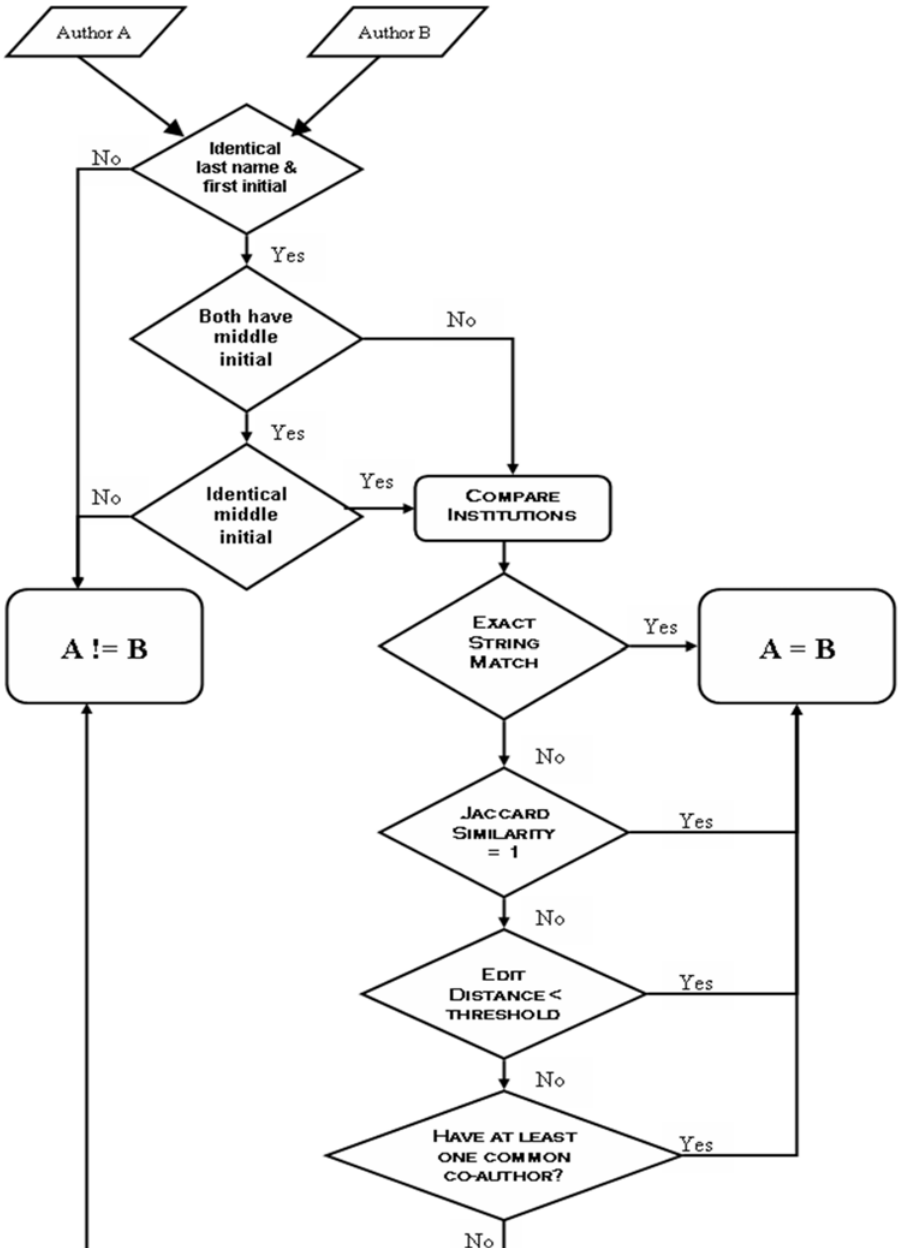
Figure 13. Work flow of determining whether two authors are the same individual.